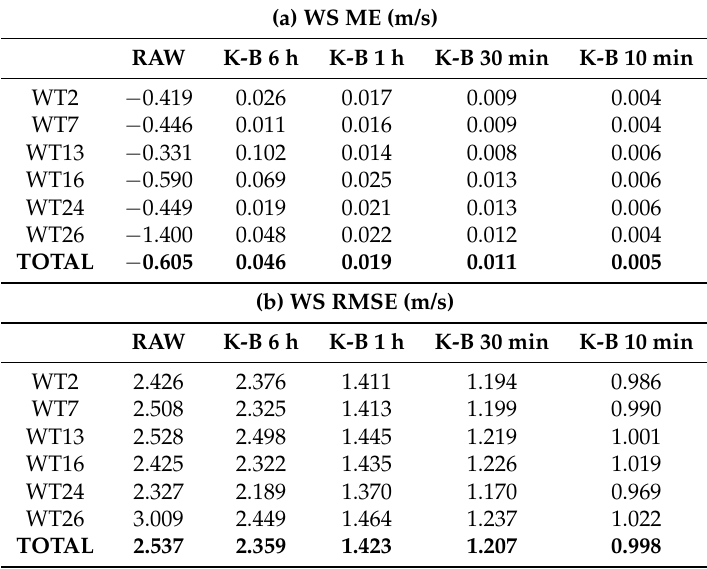
Table 3. WS ME and WS RMSE for all experiments and wind